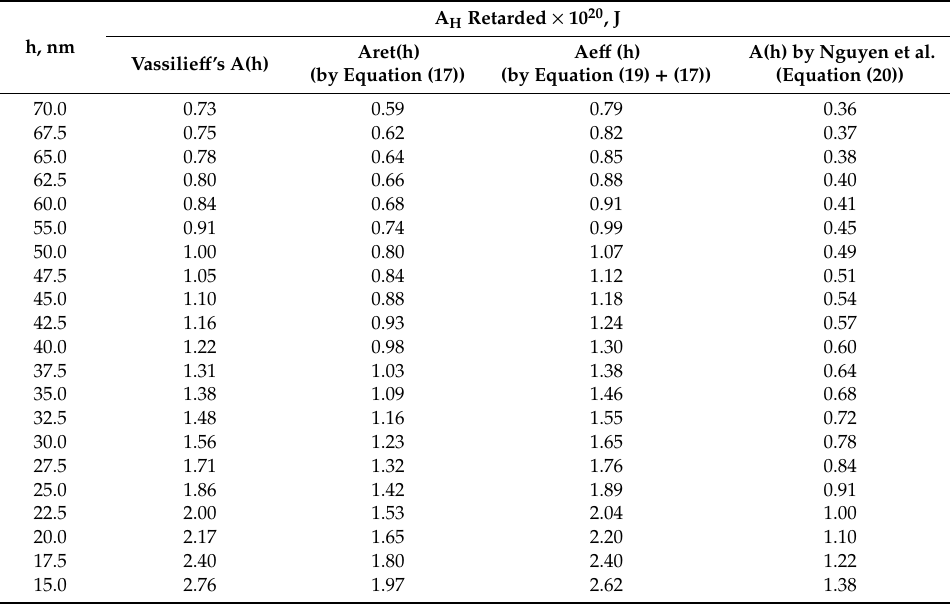
Table A1. Data of Hamaker constants obtained by di ff erent equations, taking into account the Debye screening e ff ect, for the presence of 0.1 M monovalent electrolyte.